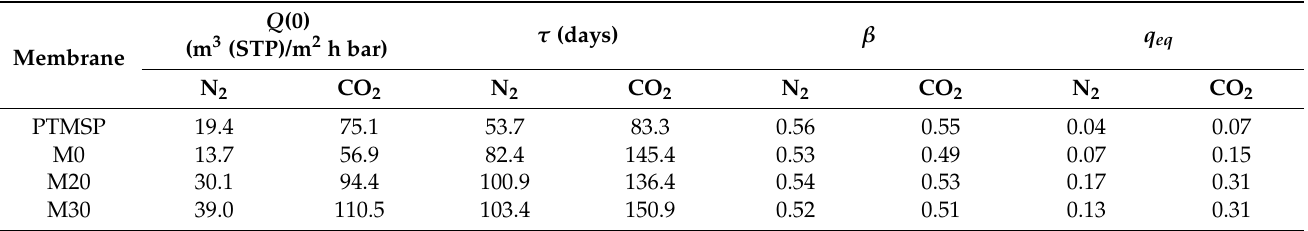
Table 1. Initial gas permeance, Q (0), through the TFC membranes and fitting parameters of “relax- ation” Equation